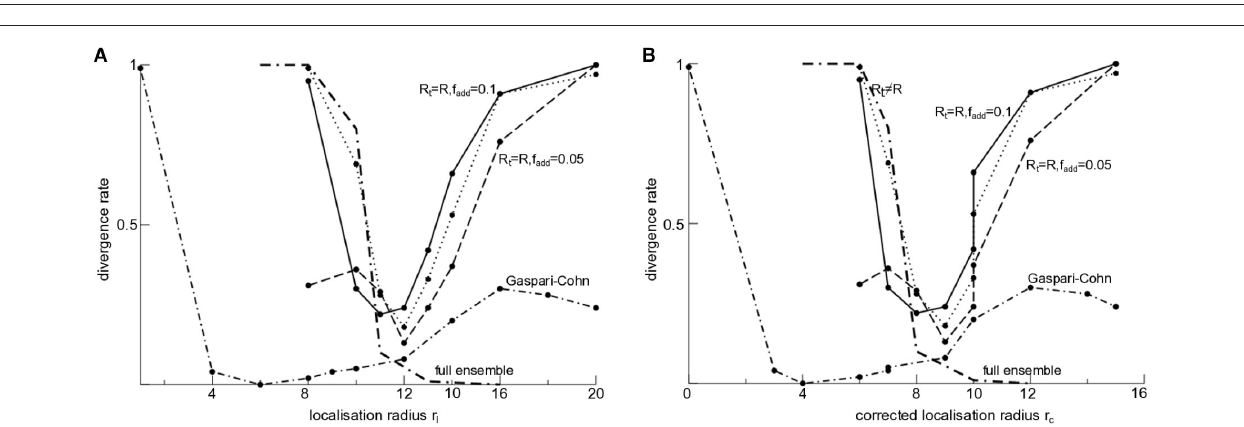
0.01. Here, the observations are noise-free with =